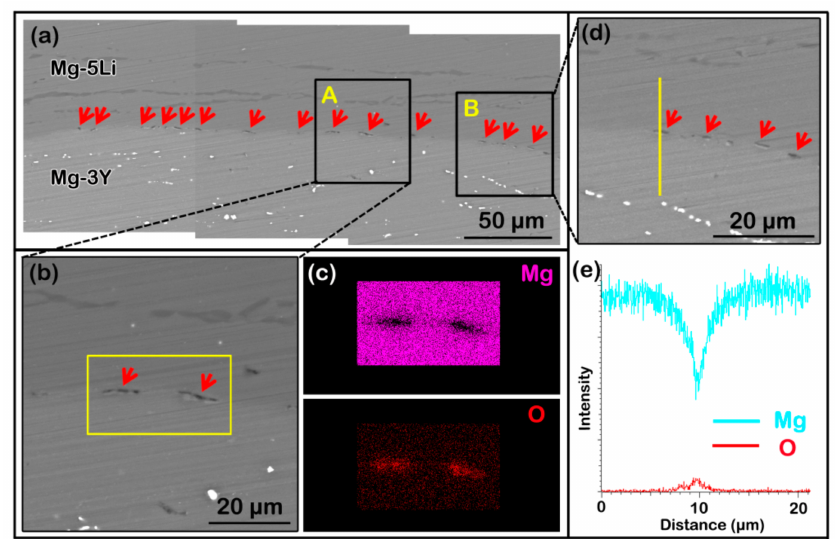
Figure 7. ( a ) SEM image of the interface of W3/L5 laminated composite including many voids labeled by red arrows; ( b ) high magnification view from black frame A in ( a ); ( c ) SEM mapping from yellow frame in ( b ); ( d ) high magnification view from black frame B in ( a ); ( e ) SEM line scanning from yellow line in ( d